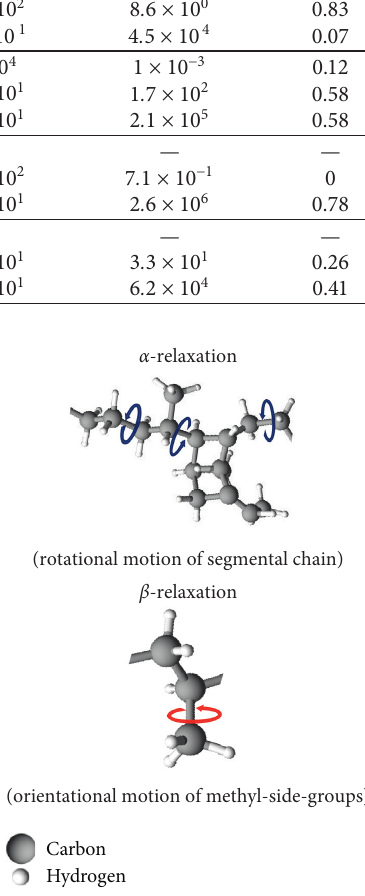
Figure 13: Assignment of the dielectric relaxation process for the schematic molecular chain structure and its motional mode in EPDM.